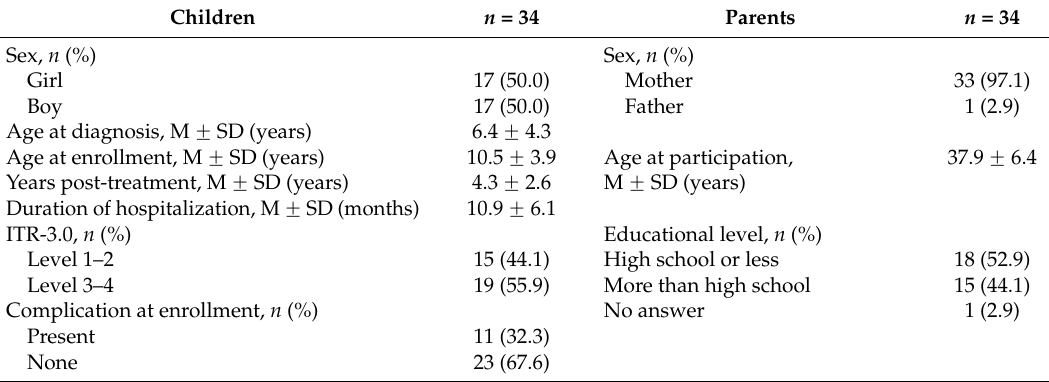
Table 1. Demographics and illness factors of enrolled children with cancer and their parents.